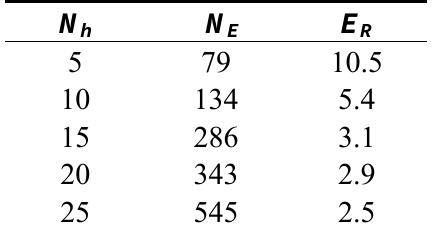
Table 1. Number of epochs ( N = 500) and values of the objective function ( E ( N r of hidden neurons ( N hidden layer is considered.